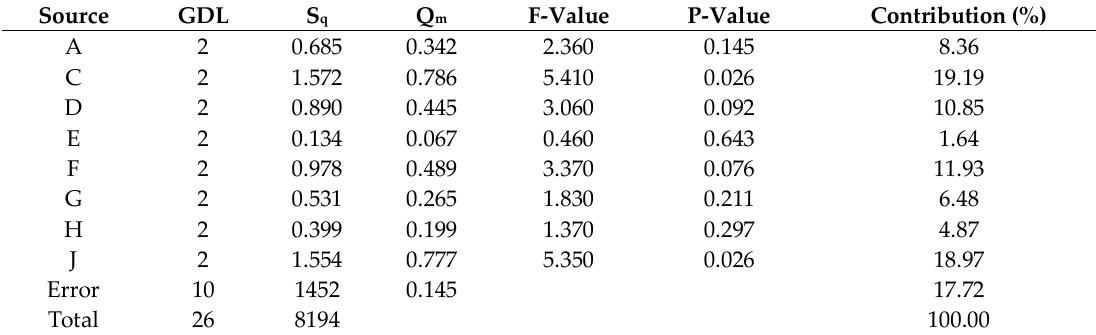
Table 5. ANOVA analysis for bead